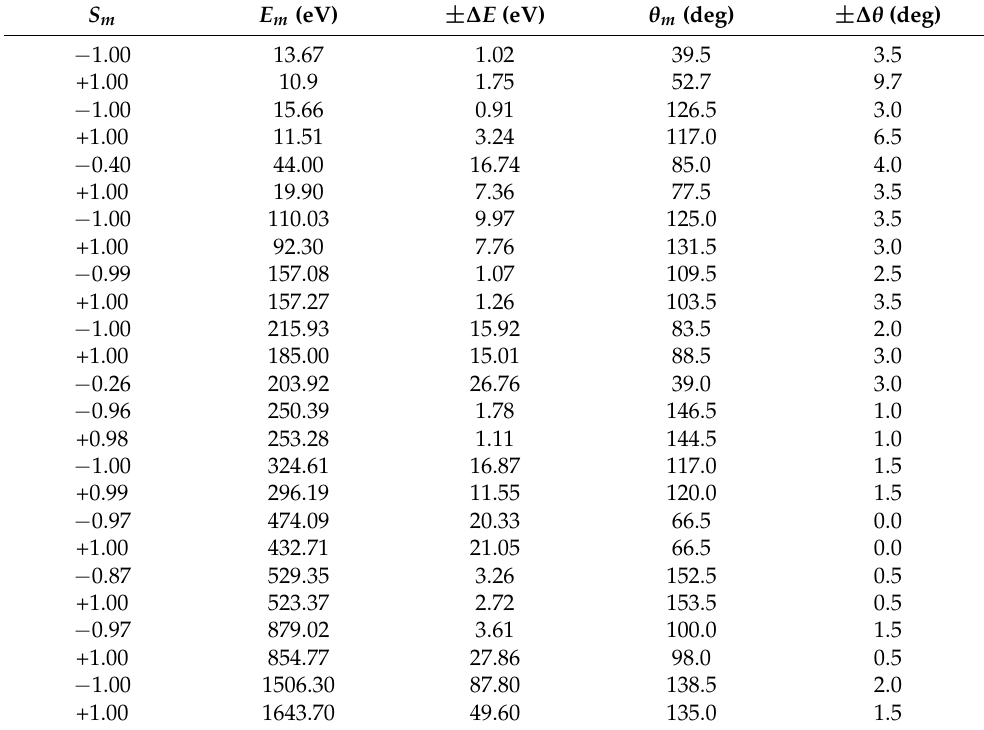
Table 8. Maximum spin polarization points with their positions and deviations in energy ( ∆ E ) and angle ( ∆ θ ) from the respective critical minimum positions for e − − Pt